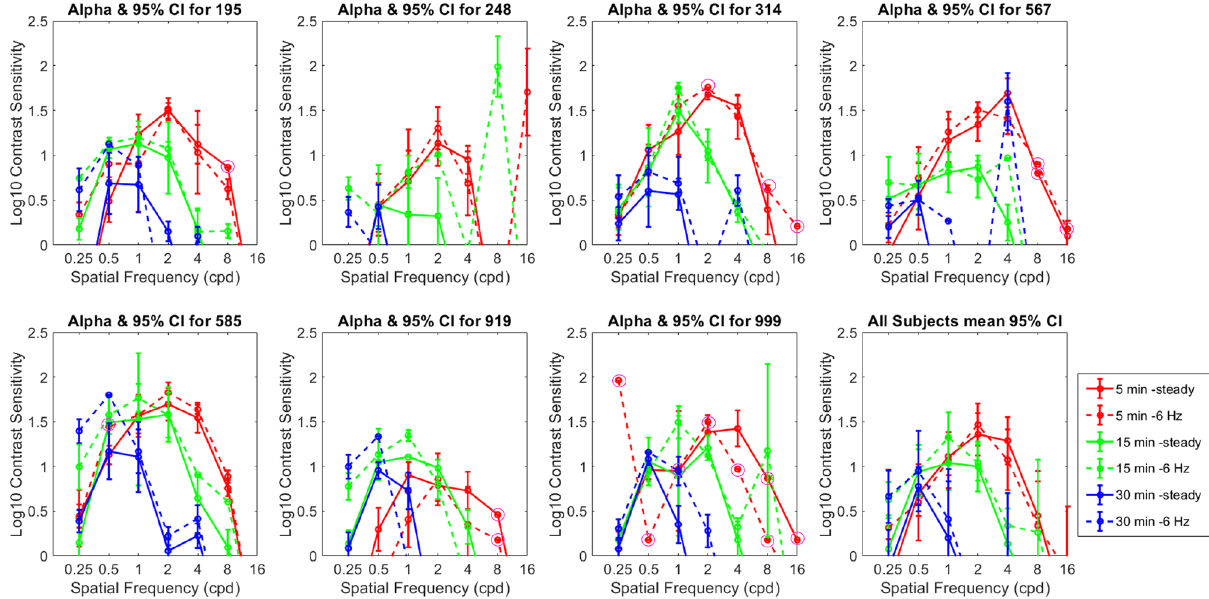
Figure 2. Vertical vergence CSFs for static vs 6 Hz flickering spatially filtered noise. The noise had a bandwidth of 1 octave and included all orientations. The Spatial Frequency values in the plot indicate the center of each noise band. Larger disparities showed a loss of response at high spatial frequencies, but similar responses at low. The CSFs for flickering and static noise are similar in shape for a given disparity. Responses at 16 cpd and above were absent or unreliable. For the most effective stimulus, a 2 cpd pattern at 5 arcmin, the peak sensitivity represents a contrast threshold of around 3%. The magenta circles around the data points indicate that our bootstrap method did not produce error bars because the beta values of the Weibull fit were too